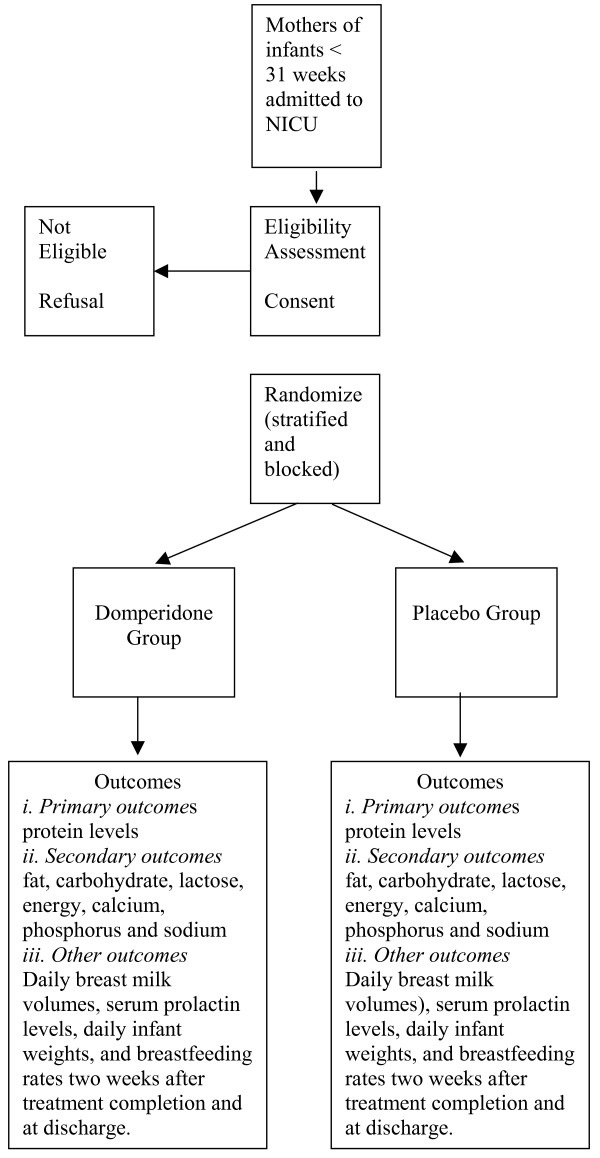
Allocation of Participants to the Trial Groups.